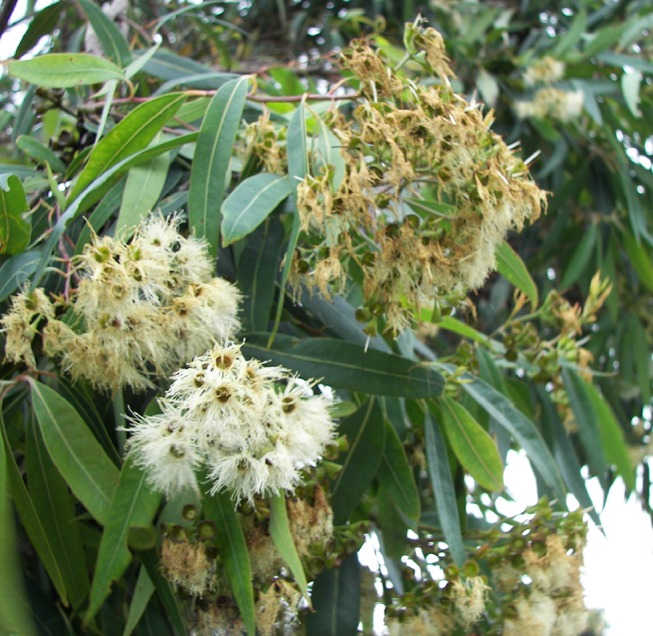

Eucalyptus flowers.